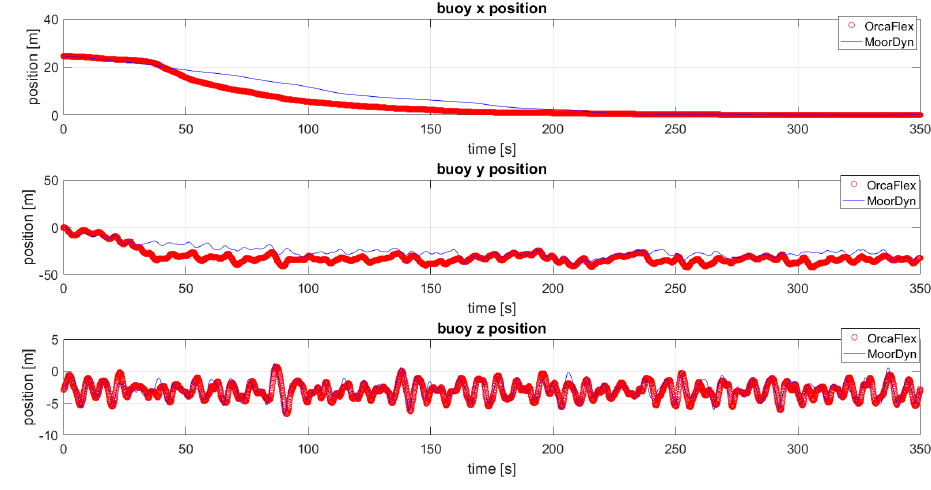
J. Mar. Sci. Eng. 2019 , 7 , x; doi: FOR PEER REVIEW Figure 12. Simulation case 3: Time series of buoy’s position. Figure 12. Simulation case 3: Time series of buoy’s position.